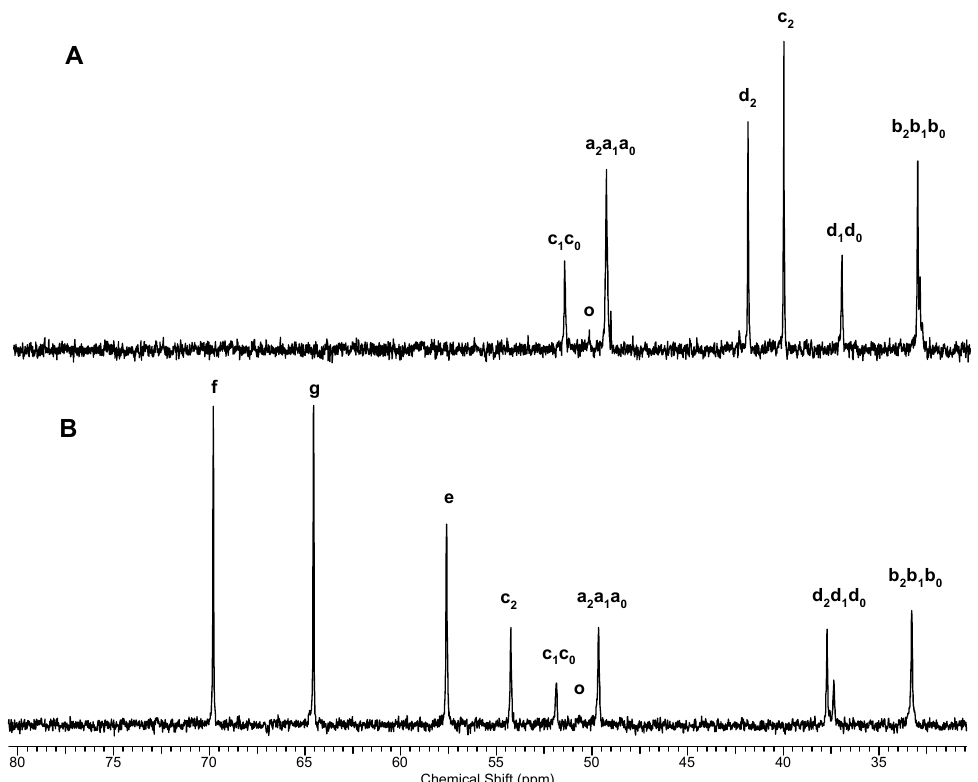
Figure 2. The 13 C NMR spectra of G2 ( A ) and G2 S gl ( B ) in D 2 O. Labeling of resonances according to the scheme shown in Figure 1.